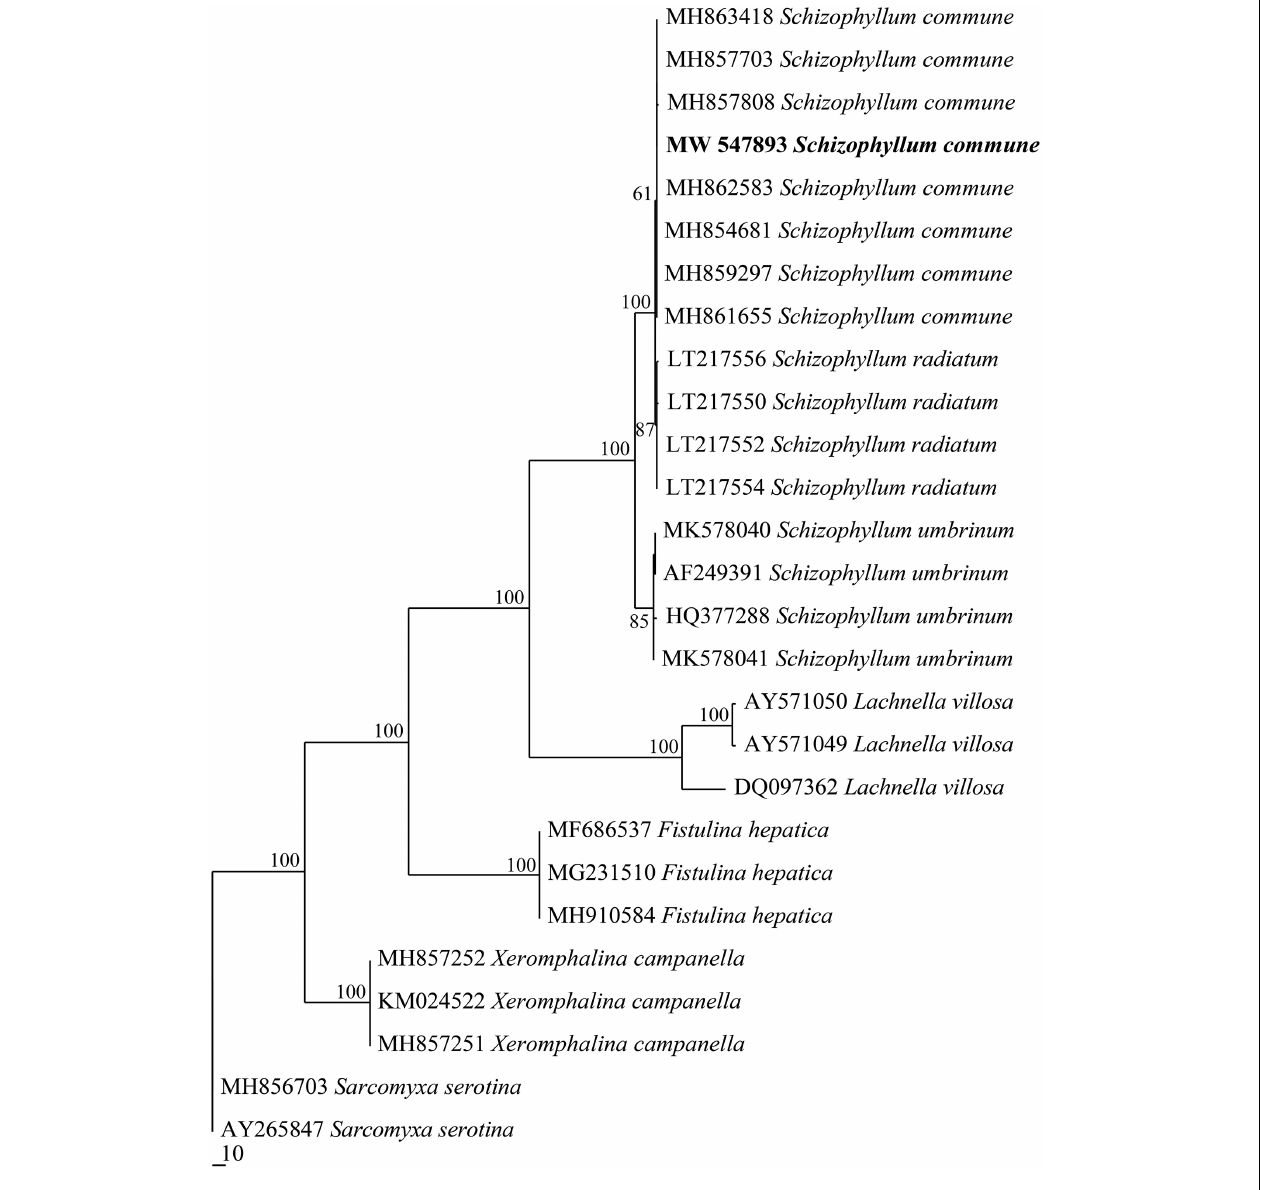
FIGURE 1 | Maximum parsimony strict consensus tree illustrating the phylogeny of Schizophyllum commune and related species based on internally transcribed spacer sequence data. Branches are labeled with parsimony bootstrap proportions high than 50%.